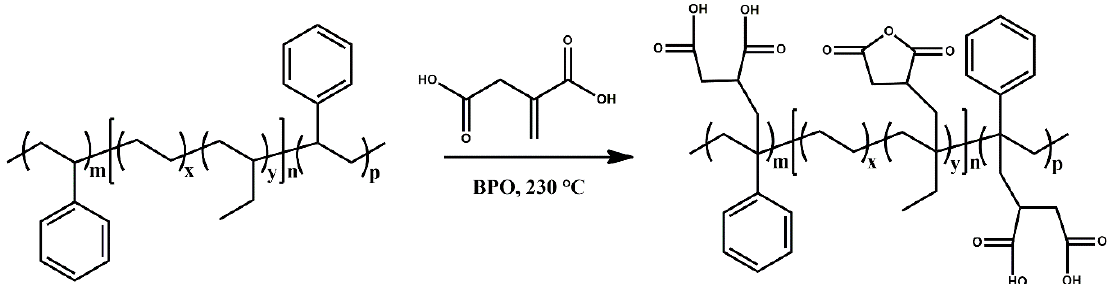
Figure 1. Scheme of grafting reaction of itaconic acid onto SEBS.